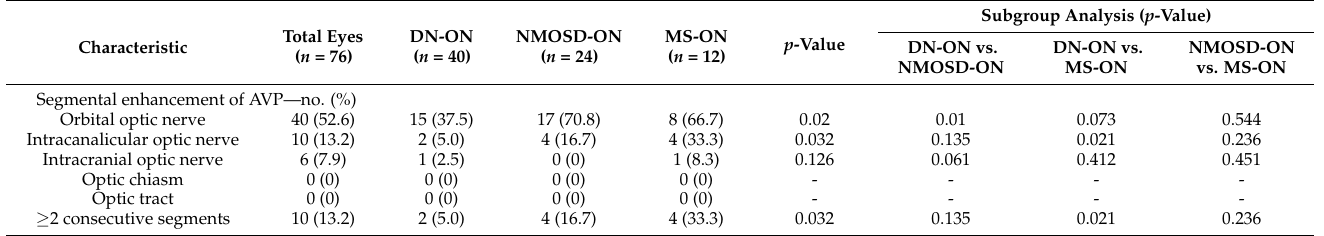
Table 2. MRI characteristics at the initial assessment of DN-ON, NMOSD-ON, and MS-ON of each affected